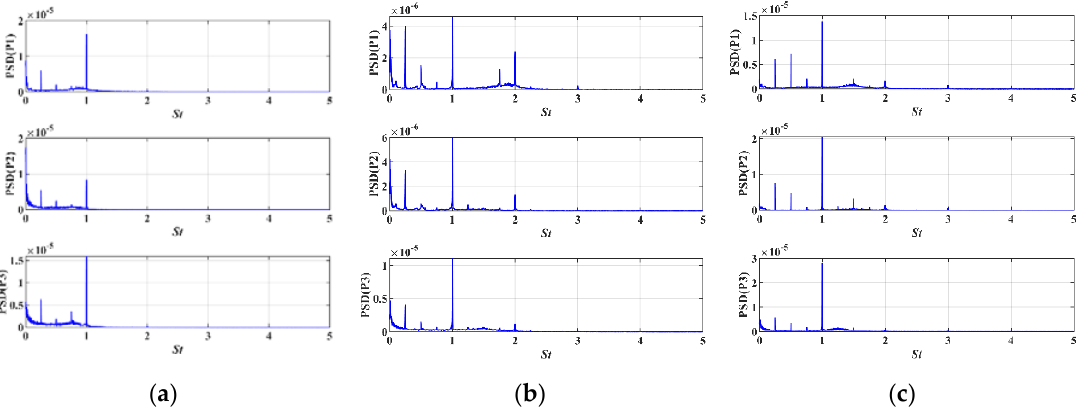
Figure 12. Frequency domain of pressure pulsations for three schemes at H d = 4.7 m: ( a ) H = 204 mm; ( b ) H = 164 mm; ( c ) H = 142 mm.